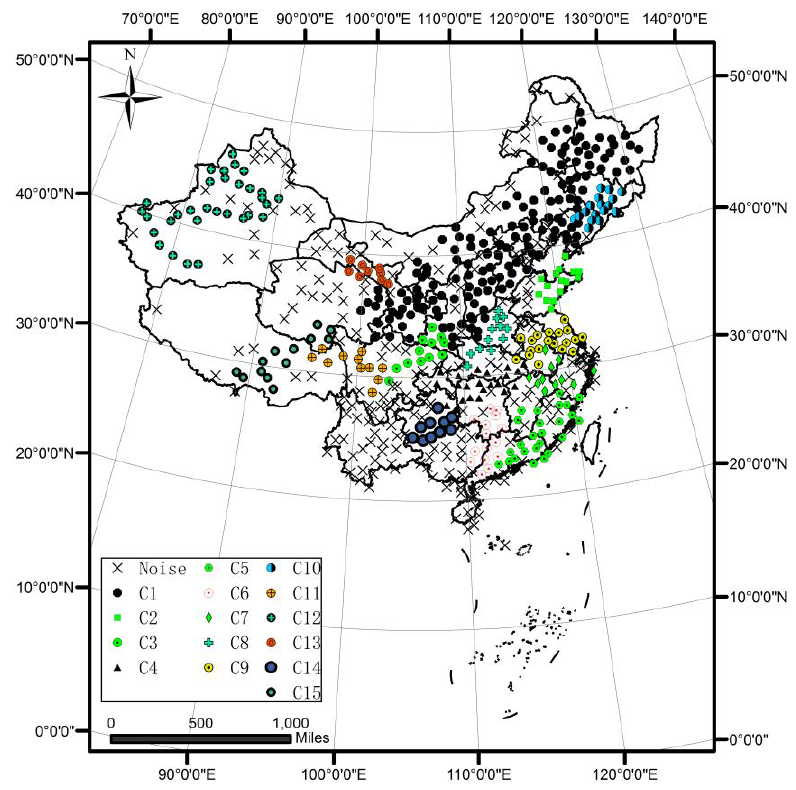
Figure 18. Clustering result of rainfall data using DTSC algorithm.